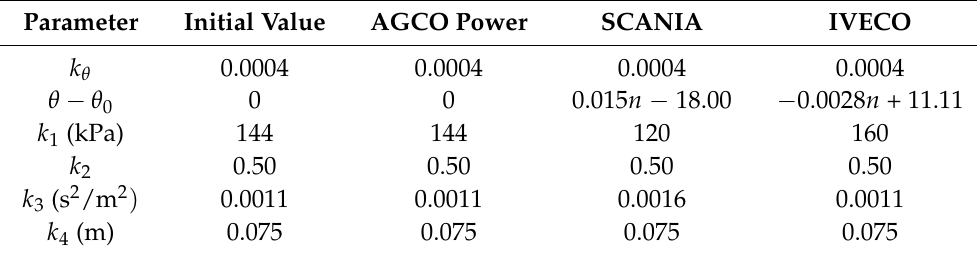
Table 5. Basic and calibrated parameters of each engine